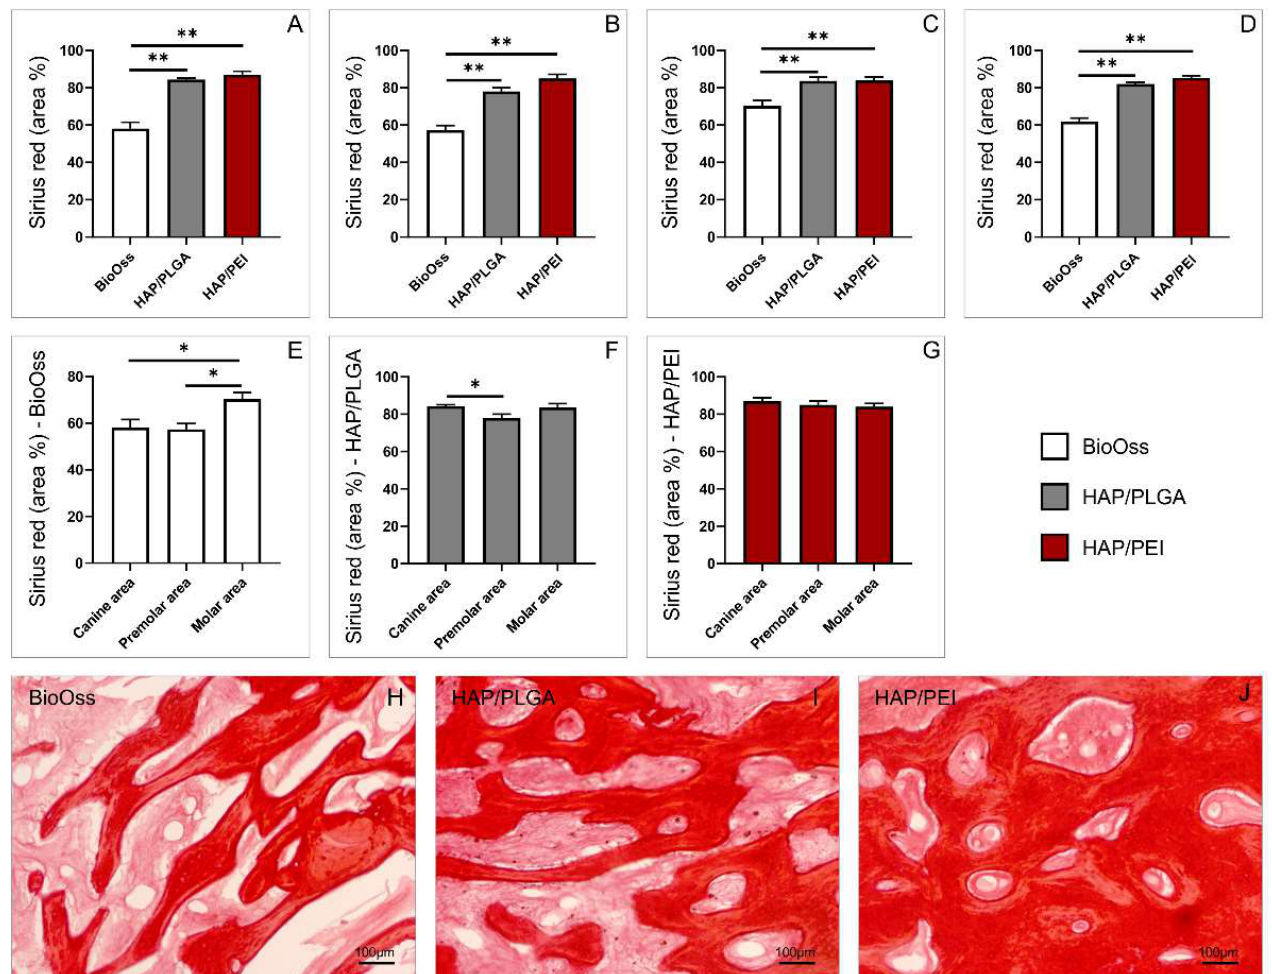
Figure 4. Collagen deposition in the newly formed bone tissue: ( A ) canine area, ( B ) premolar area, ( C ) molar area, ( D ) whole mandibula, ( E ) BioOss graft, ( F ) HAP/PLGA graft, ( G ) HAP/PEI graft; Representative images of H&E staining on paraffin-embedded sections (original magnification × 20): ( H ) BioOss graft, ( I ) HAP/PLGA graft, ( J ) HAP/PEI graft. The values are mean ± standard error of the mean (SEM), * denotes a significant difference p < 0.05, ** denotes a significant difference p < 0.01.